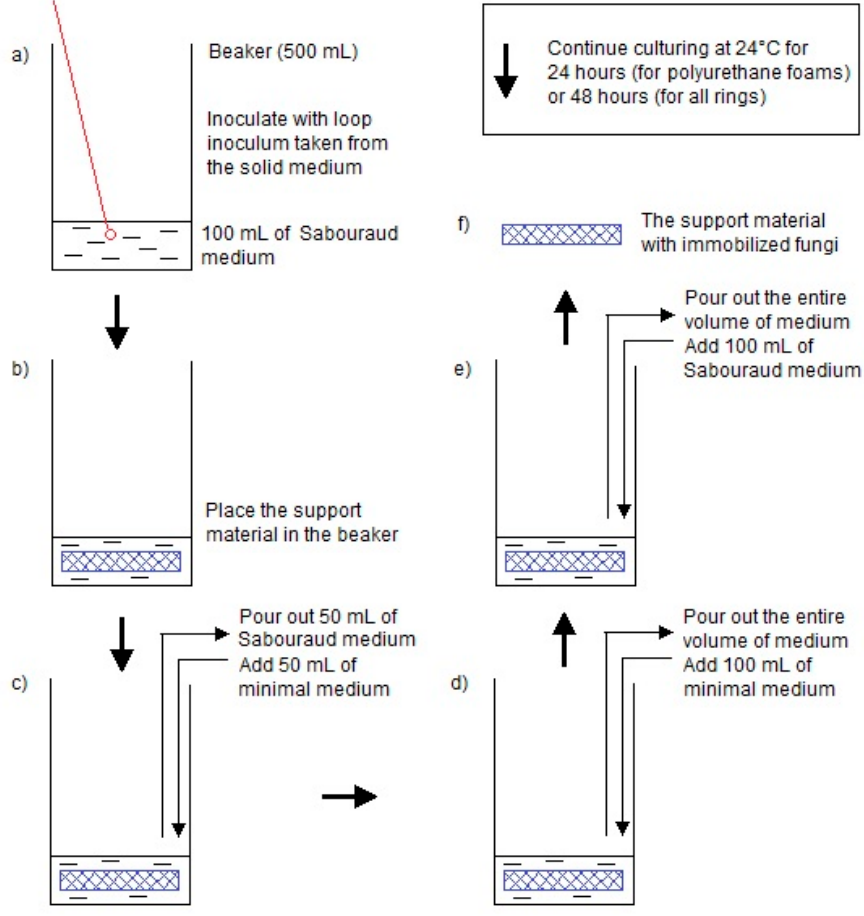
Figure 2. Scheme ( a )–( f ) showing immobilization of selected fungi on the support Figure 2. Scheme showing immobilization of selected fungi on the support materials.